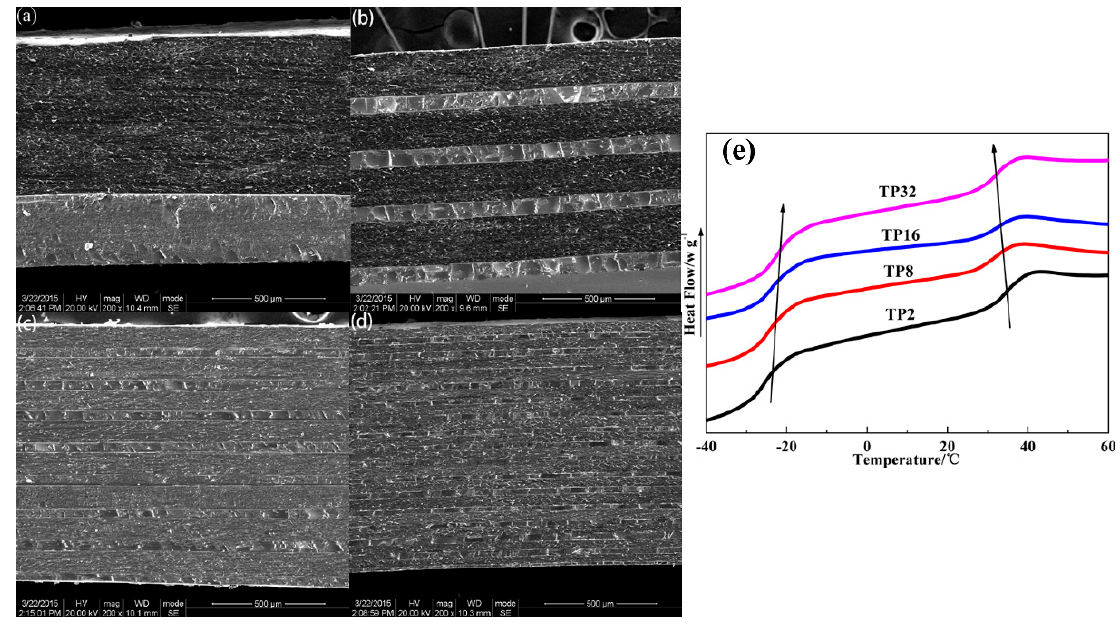
Figure 3. ( a ) SEM image of TP2; ( b ) SEM image of TP8; ( c ) SEM image of TP16; ( d ) SEM image of TP32 and ( e ) differential scanning calorimetry (DSC) curves of TP hybrids.